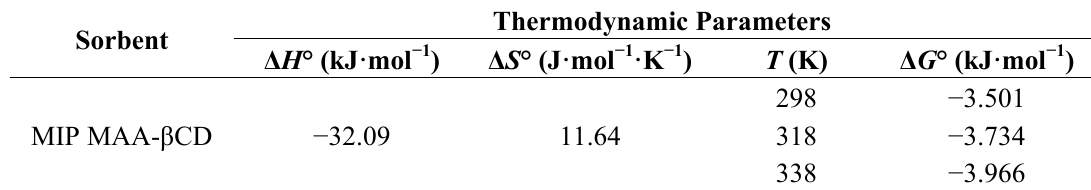
Table 3. Thermodynamic adsorption